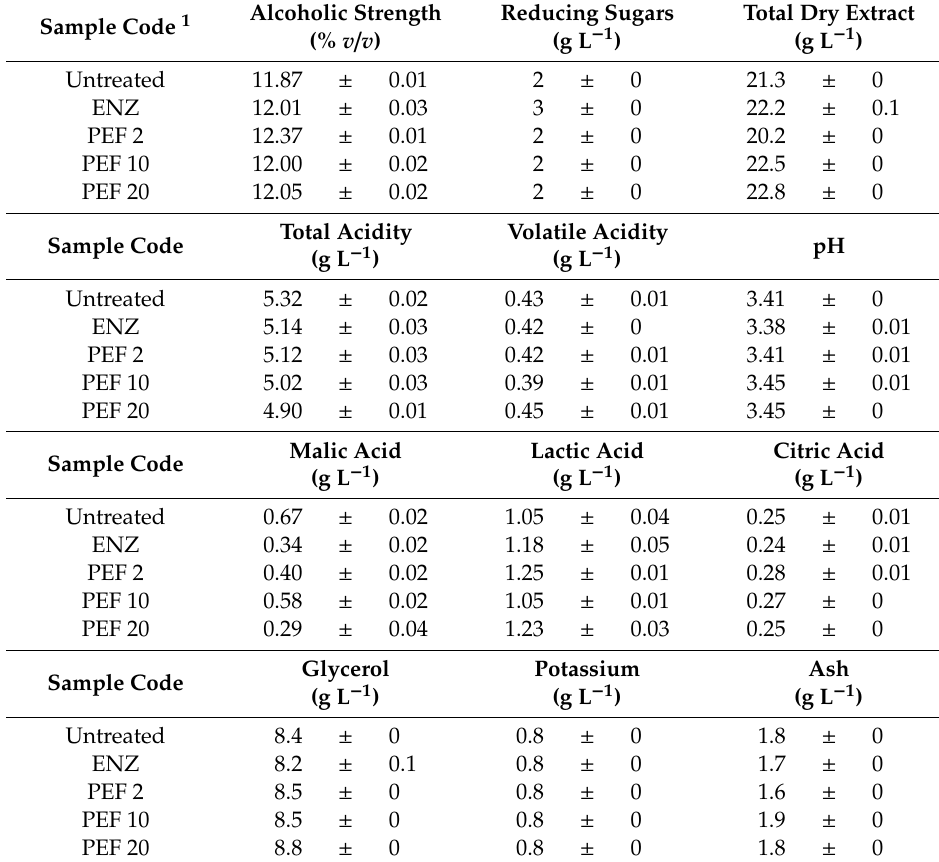
Table 1. Basic analytical parameters (means ± SD) detected in the wines after twelve months of bottle